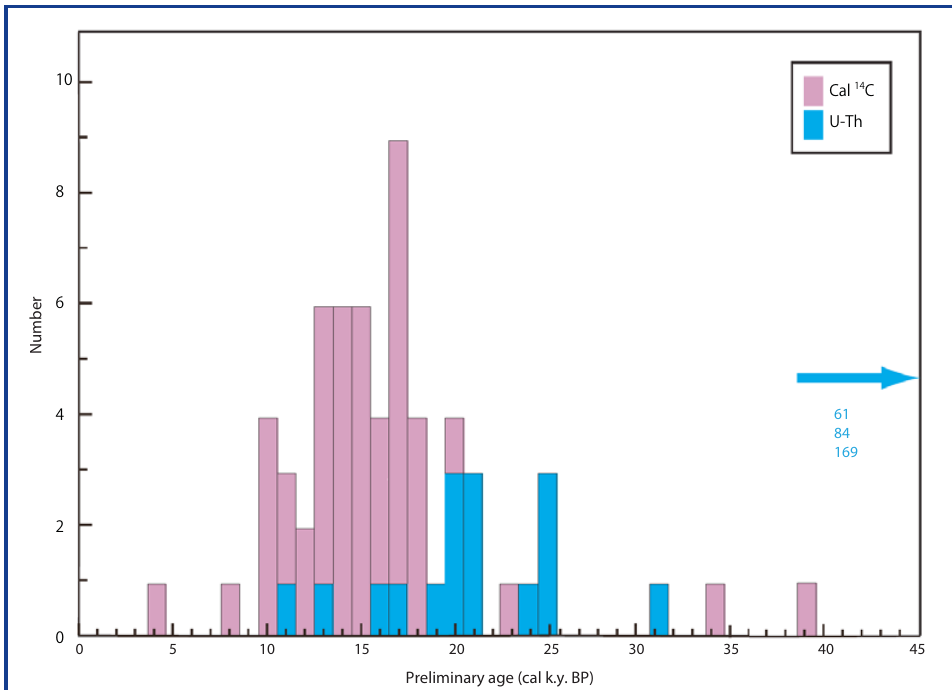
Figure 8. Age histograms of preliminary dating samples (1-ky rounded). All ages are in years before AD 1950. Numbers in blue listed below the arrow indicate 3 U/Th ages obtained for older